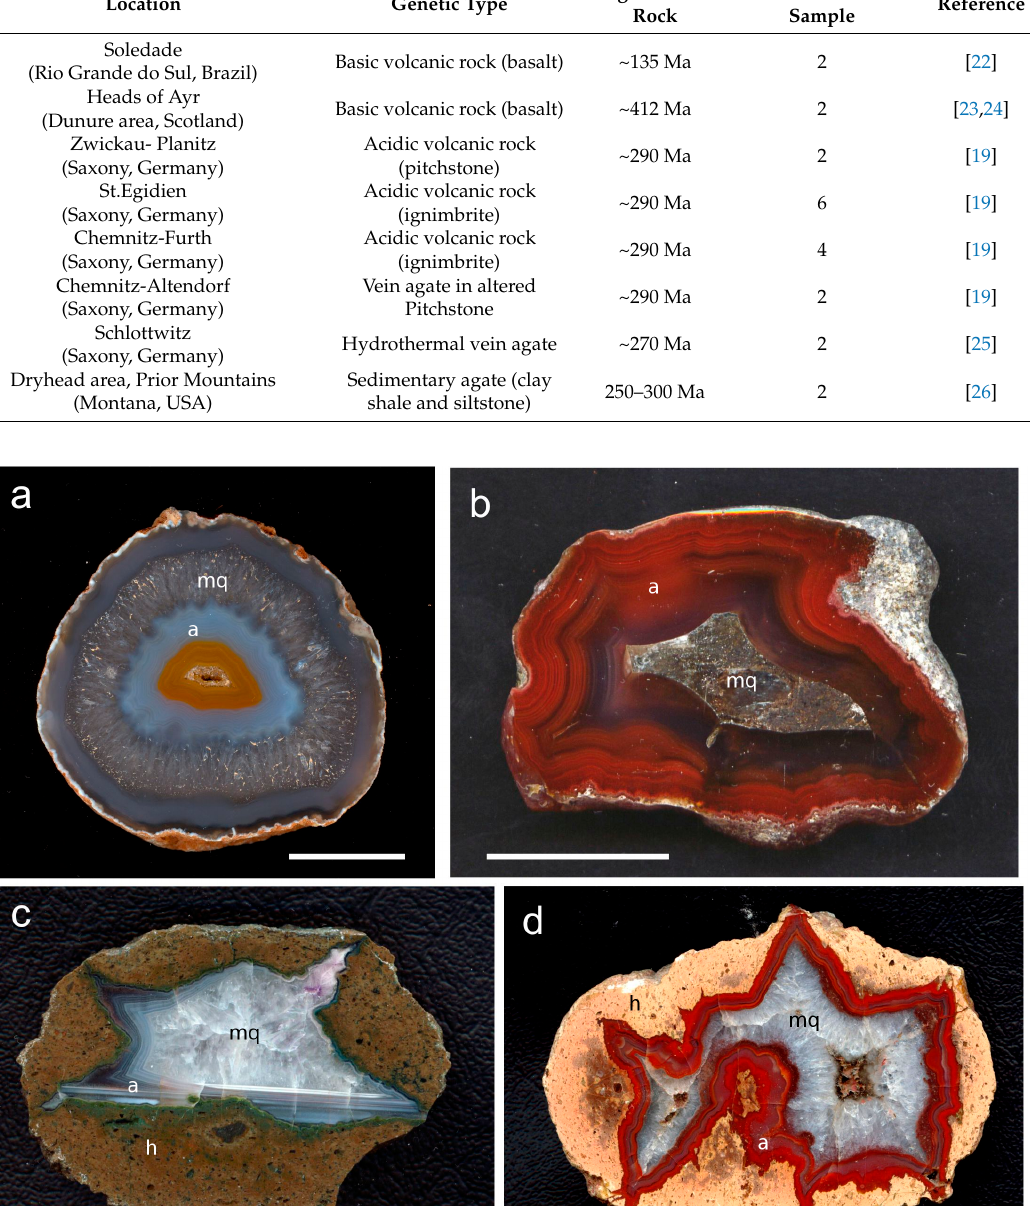
Table 1. Compilation of the investigated agate samples and their genetic types.